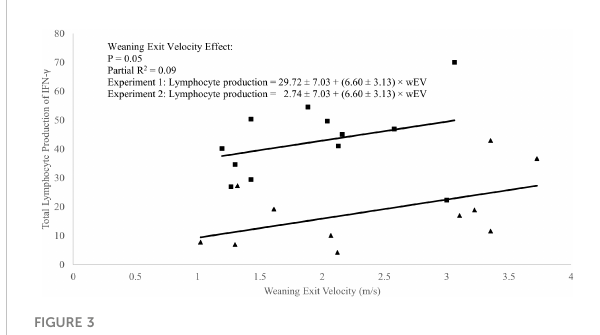
FIGURE 3 Regression of total in vitro lymphocyte production of interferon- g against weaning exit velocity (wEV) during two experiments utilizing heifer calves. Experiment 1 (n = 12 heifers) data is a three-week baseline average of total lymphocyte production of IFN- g beginning one week after calves were placed in barn. Experiment 2 (n = 11 heifers) data were from a single collection on the day calves were placed in the barn. One data point was removed from experiment 2 data due to an insuf fi cient number of cells harvested from the sample. PBMCs were isolated from whole blood collected weekly via jugular venipuncture, treated with transport inhibitor brefeldin A, and stimulated with phorbol 12-myristate 13-acetate + ionomycin. Experiment 1 ( ■ ). Experiment 2 ( ▲ ). Experiment was a signi fi cant source of variation (P < 0.01) but there was no interaction between experiment and wEV (P = 0.98).